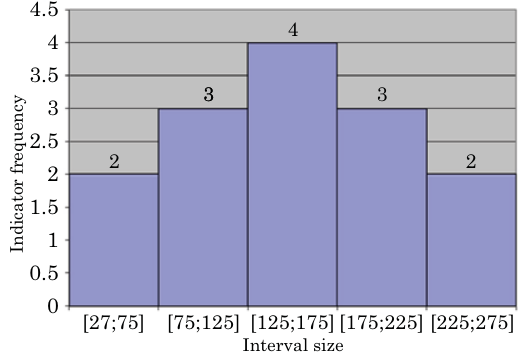
fig. 2. Histogram of the distribution of the importance of the economic lease indicators